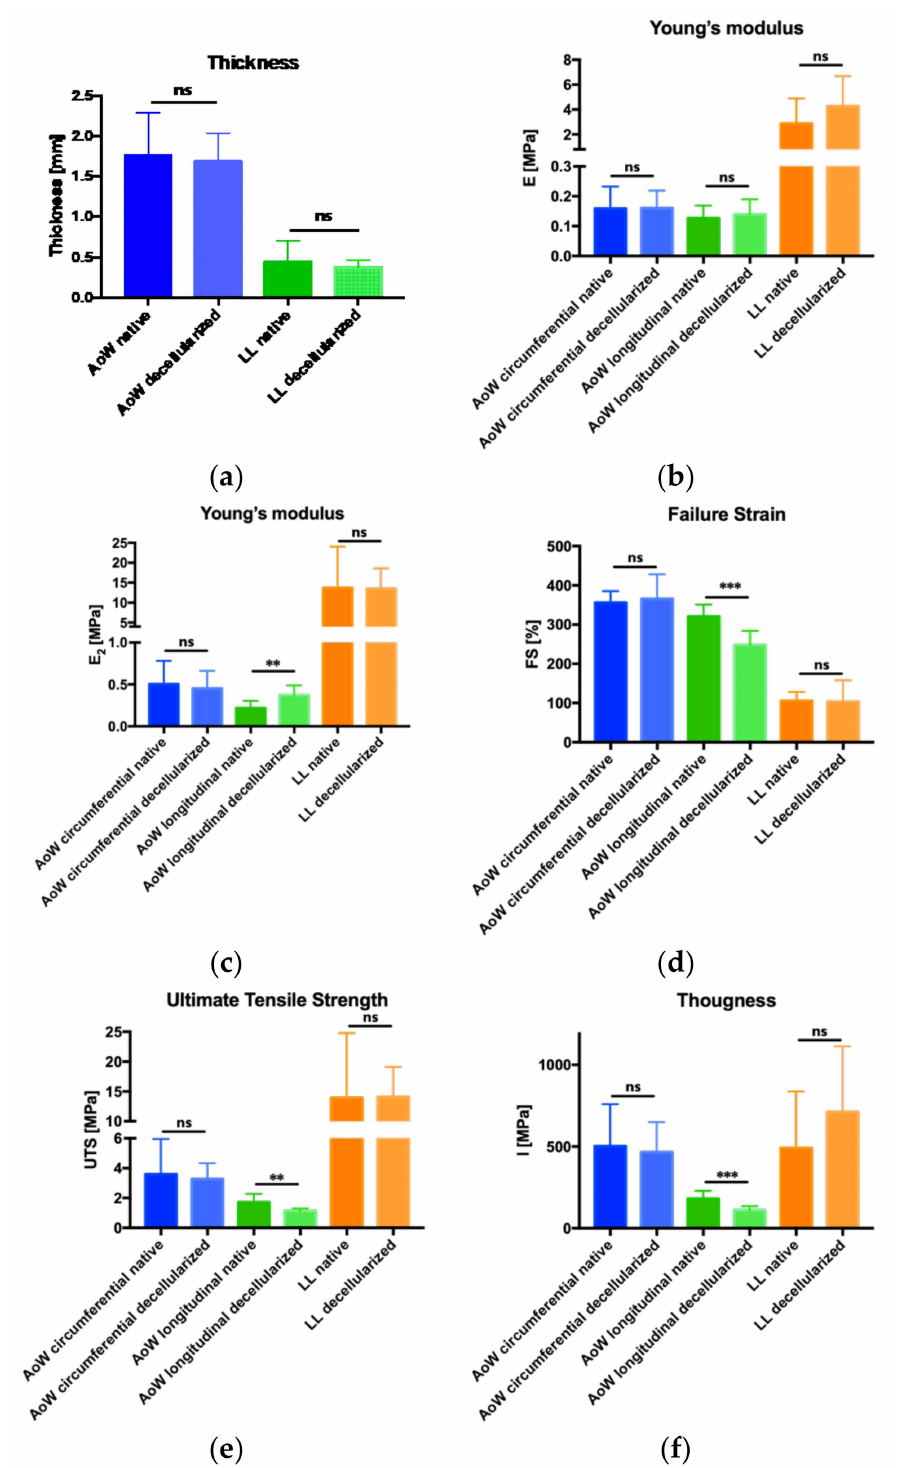
Figure 3. Histograms of mechanical tests. Sample thickness are not statistically different comparing native and decellularized samples ( a ). Modulus E1 values are not statistically different ( b ), whereas modulus E2 values are statistically different for the longitudinal aortic wall comparing samples before and after decellularization ( c ). These samples are statistically different also in terms of failure strain ( d ), ultimate tensile strength ( e ) and toughness ( f ) (ns: no significant different, ** p < 0.001, *** p <